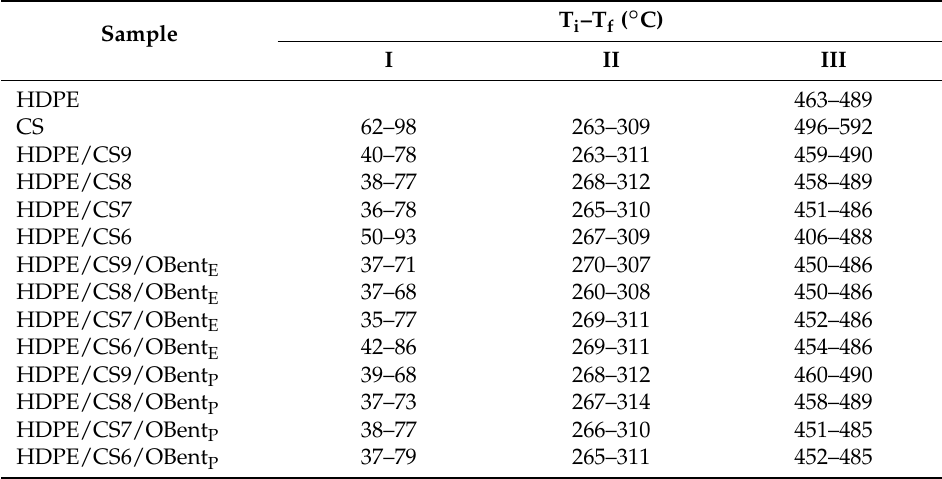
Table 3. Characteristics temperatures of the degradation step of the HDPE, chitosan (CS), HDPE/CS, and HDPE/CS/OBent with different